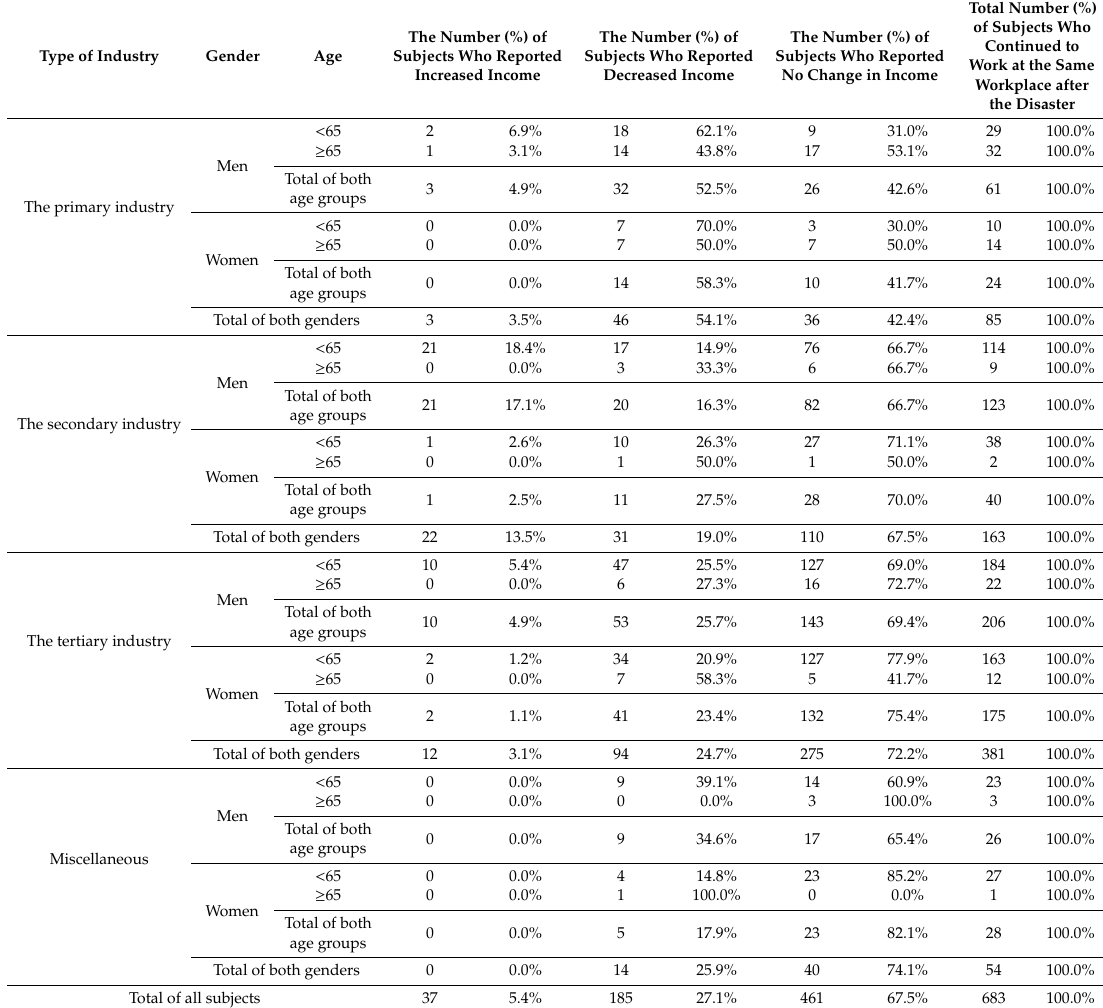
Table 5. Changes in income among subjects who continued to work at the same workplace after the Great East Japan